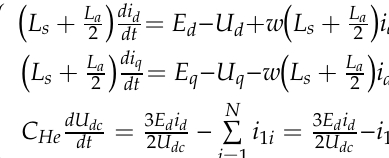
Figure 3. Topology of a DC microgrid system.